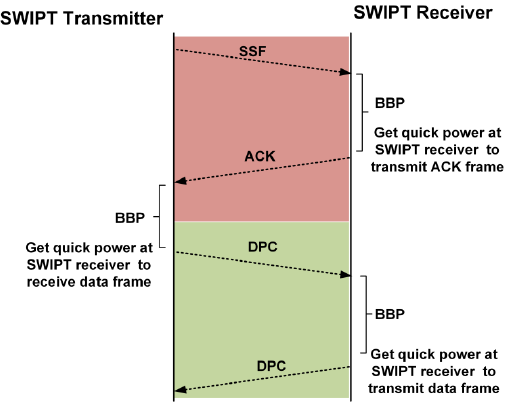
Figure 13. Transmission of the ACK frame after the BBP at the SWIPT receiver.